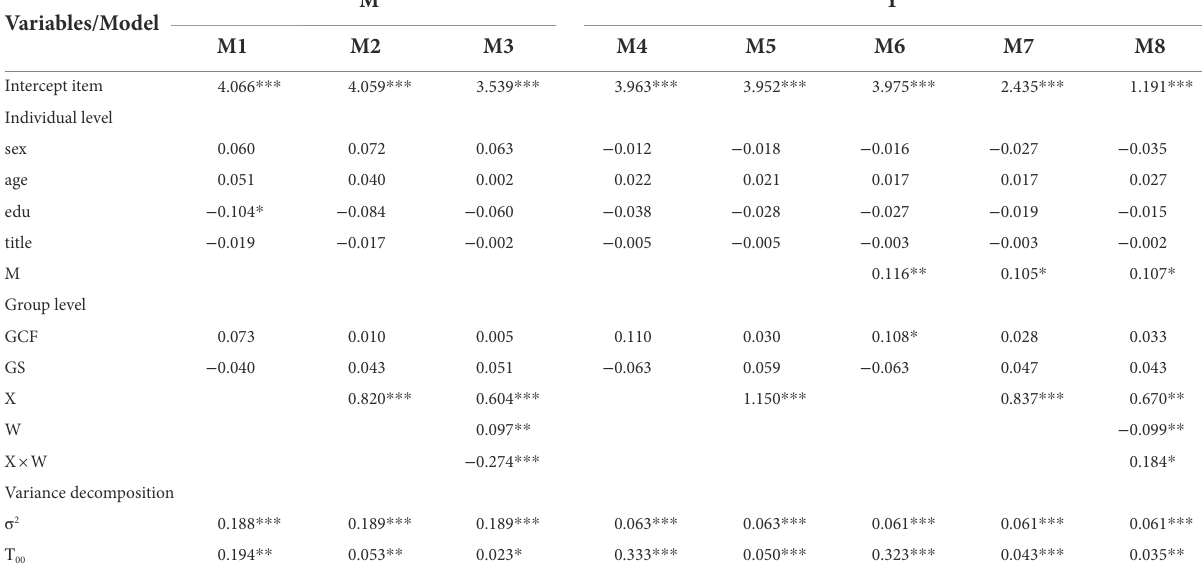
TABLE 4 Cross-level model test results ( n =